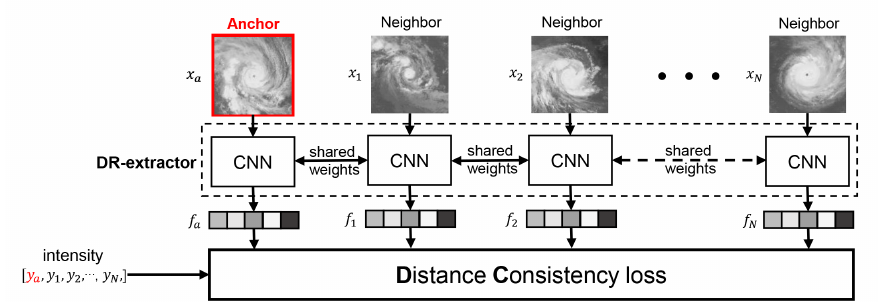
Figure 3. Training details of DC loss. We construct a (N + 1)-tuplet of training samples with an anchor and N neighbors and feed them to DR-extractor. Finally, we calculated the DC loss of feature embeddings and